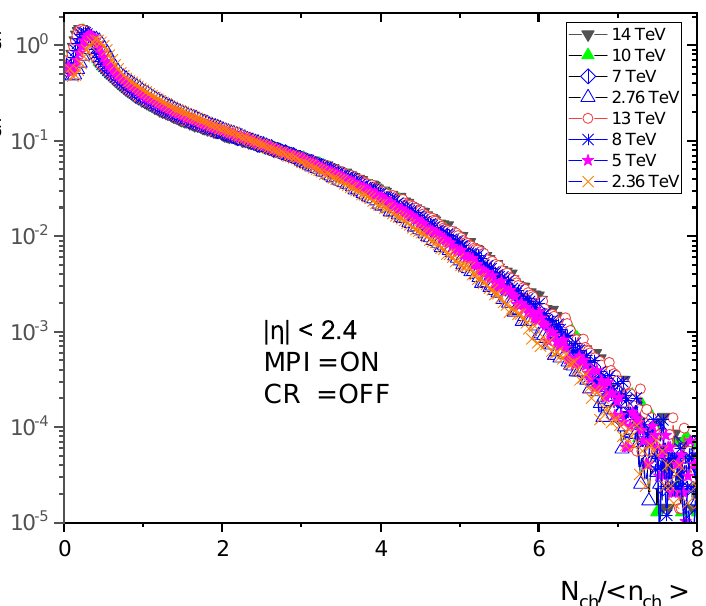
Figure 15. KNO form of charged particle multiplicity distribution at different energies in pseudora- pidity | η | < 2.4 with MPI = ON and CR =